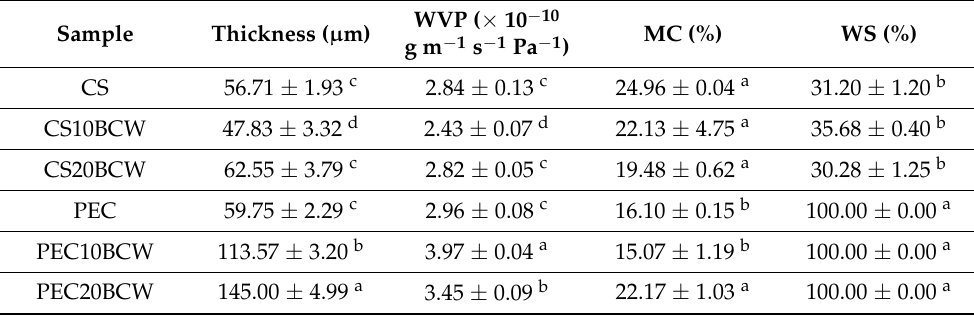
Table 1. Thickness, water vapor permeability (WVP), moisture content (MC) and solubility in water (WS) of CS and PEC films with or without blackcurrant powder at different concentrations.